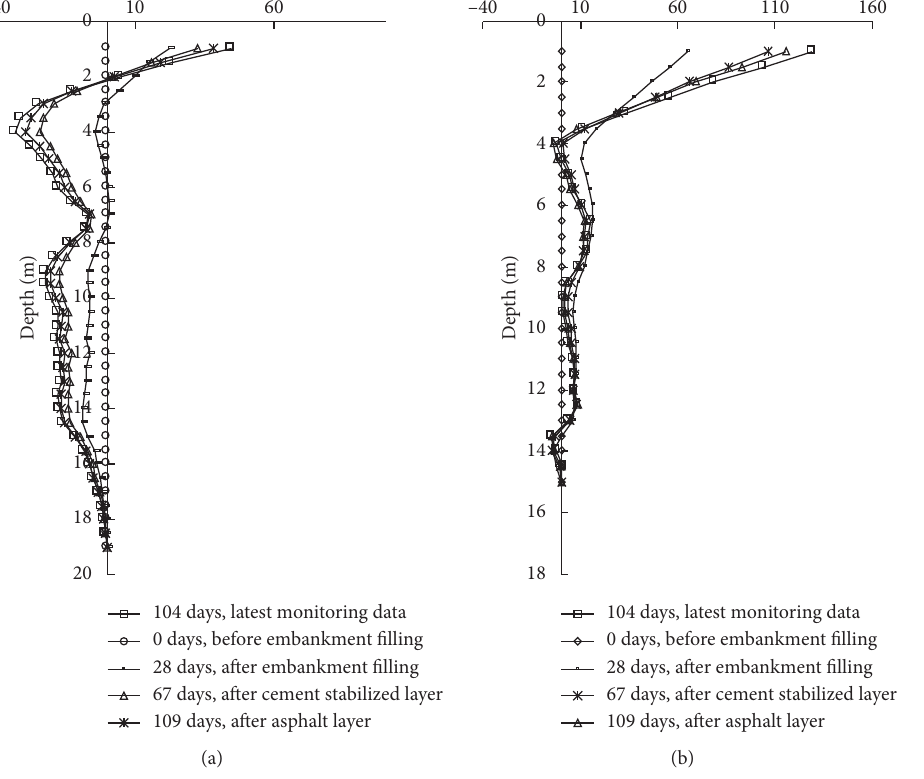
Figure 20: Variation of cumulative horizontal displacement in different construction stages. (a) Left embankment. (b) Right